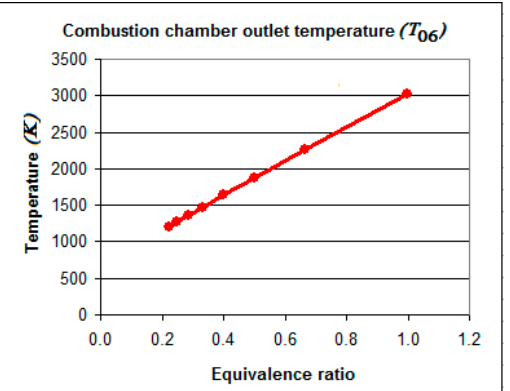
Figure 12. Efficiency of the main rotor and double-rotor engines for the range of inlet Mach numbers as a function of the equivalence ratio.